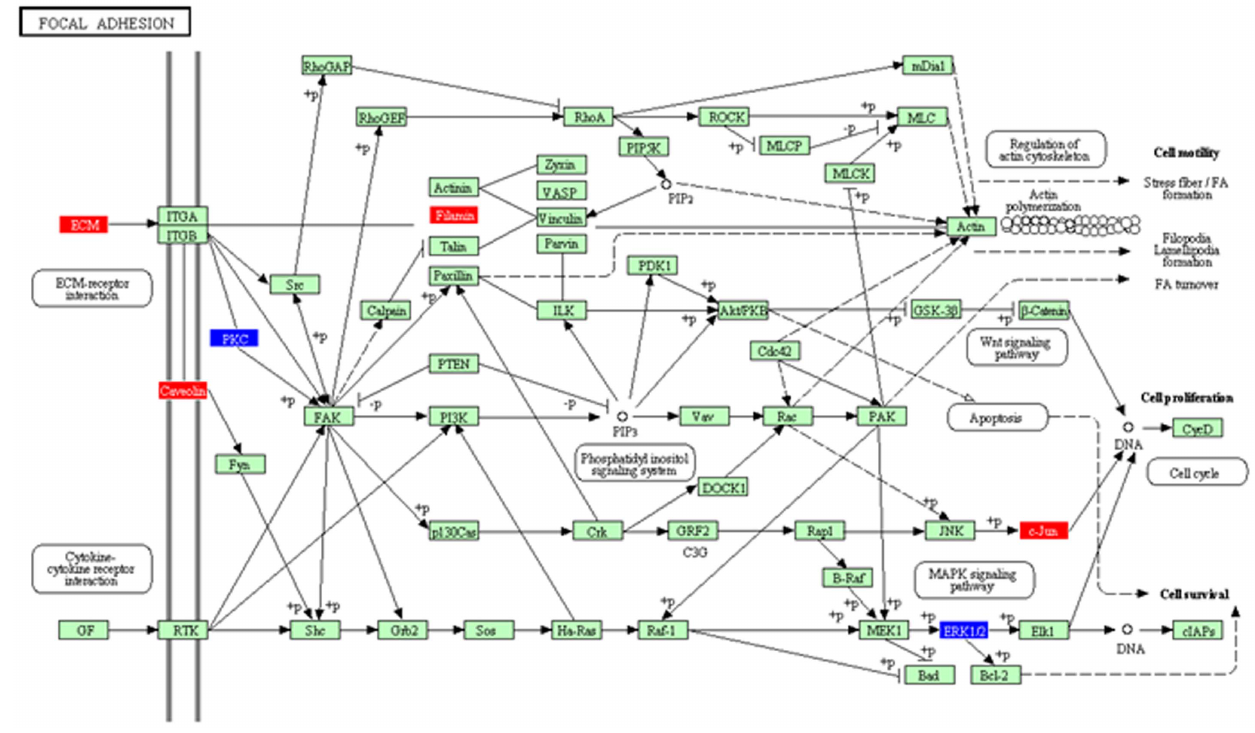
Figure 7. KEGG pathway analysis showed the upregulation of Focal adhesion pathway in GBM. 67 differentially expressed genes between AA and GBM from GSE1993 was subjected to network analysis in Pathway Express which identified the focal adhesion as the significantly differentially regulated pathway between AA and GBM. The input genes present in the network are represented in red and blue indicating the upregulation or downregulation respectively in GBM as compared to AA.